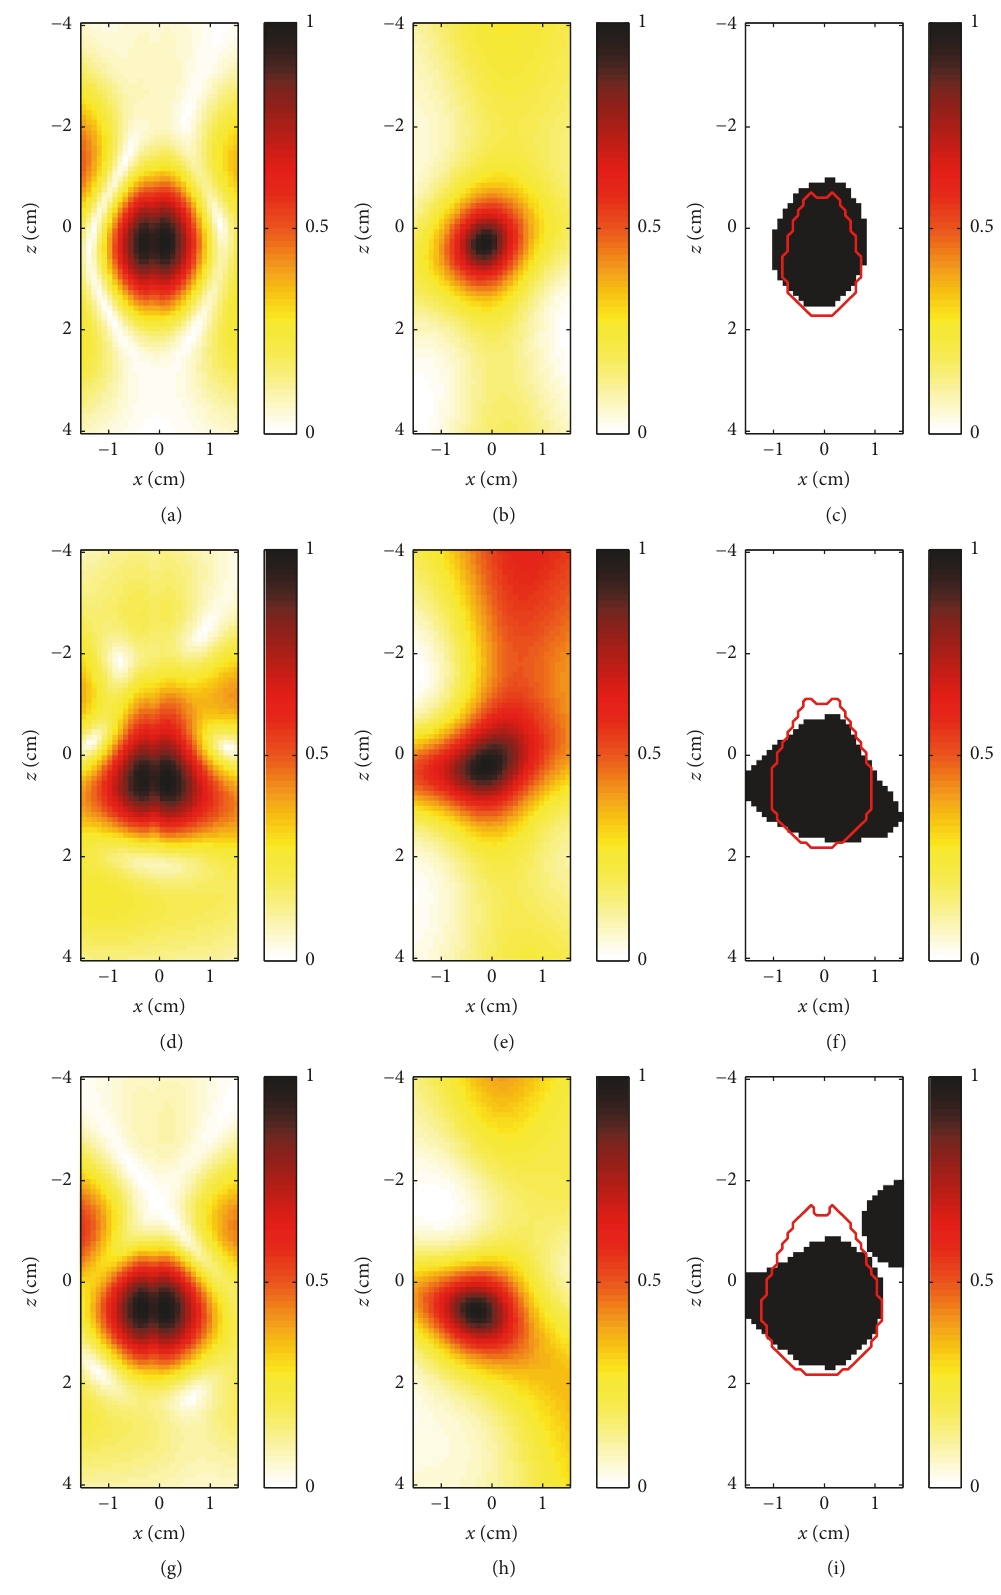
Figure 7: Reconstructions of the electric variations due to the ablation treatment using reduced antennas configuration (5 antennas) for the TSVD (a, d, g) and LSM (b, e, h) algorithm and −3 dB cuts of fusion images (c, f, i), adopting a SNR equal to 80 dB, at 60 s (a, b, c), 120 s (d, e, f), and 180 s (g, h, i). The shape of the actual ablated area is superimposed (red line) to the fusion